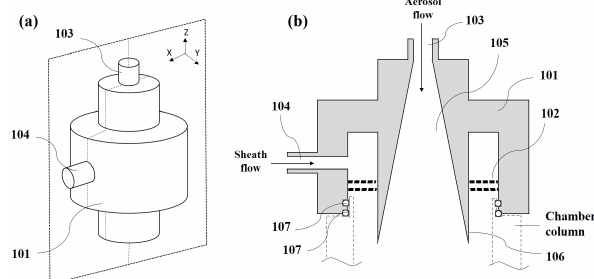
Figure A1. (a) Front view of an embodiment of the diffusive in- let. (b) Longitudinal sectional (the cross section in X – Z surface) view of (a) . Each number in the figure is as follows: main body (101), a sheath flow straightener (102), an aerosol inlet (103), a funnel-shaped region (105) where the cross section of the aerosol is smoothly expanded, the angle (106) of the wall of the funnel- shaped region, the inlet of sheath air (104) at the side of the main body, and two rubber O-rings (107) at the lower end of the main body to keep the activation tube airtight.